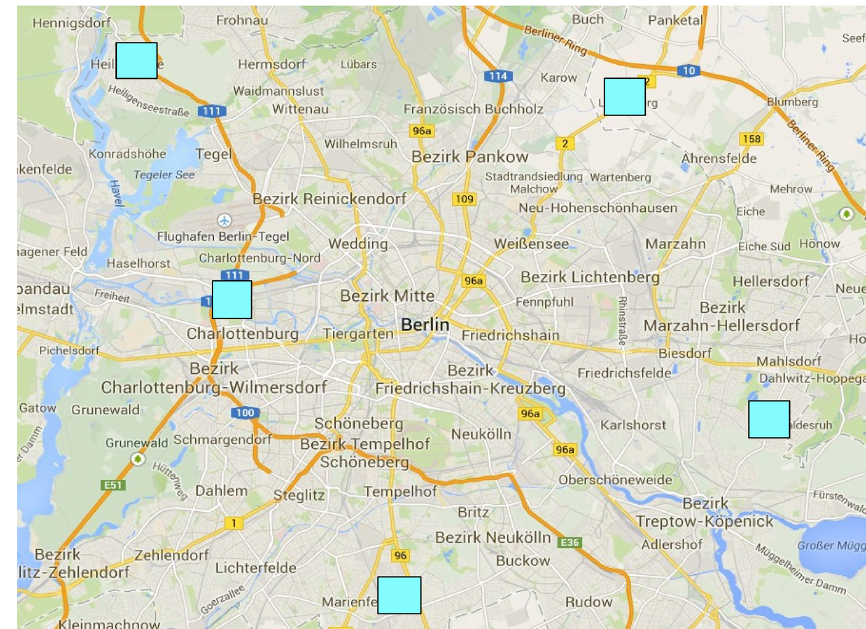
Figure 1. Map showing the measurement stations around Berlin.